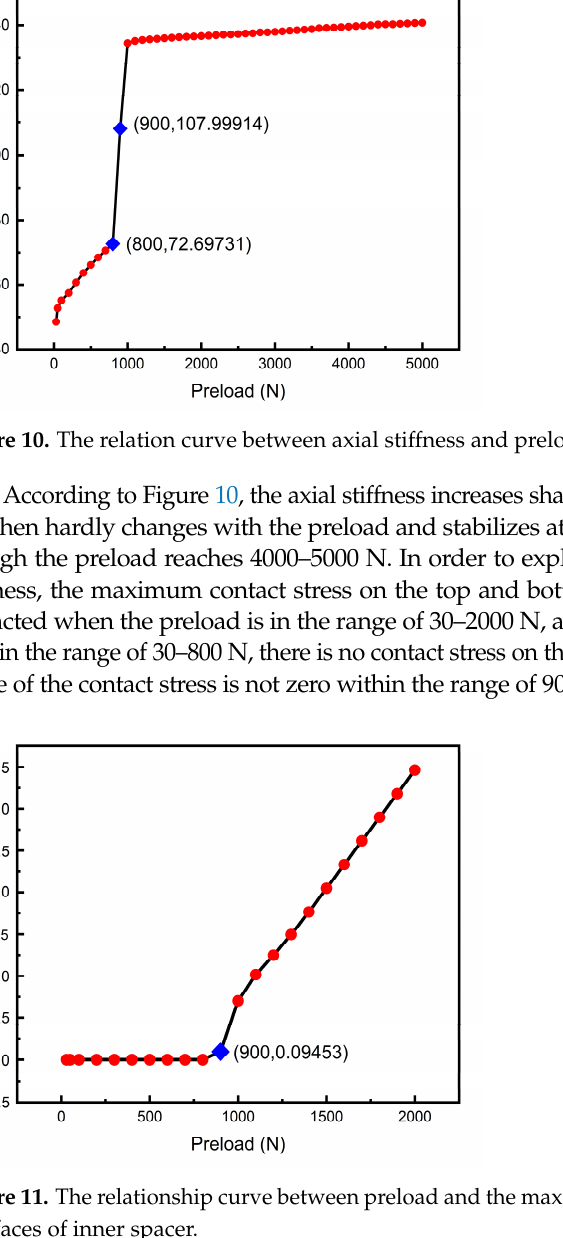
13 of 16 Figure 9. Comparison of F-l curve of bearing’s 2D model and fitting curve of stickout measuring experiment results. It can be concluded that the relationship curve between force (F) and displacement (l) calculated for the bearing equivalent 2D simulation model is well fitted with the ex- perimental results. Therefore, the stiffness of the actual bearing can be well simulated by using the 2D axisymmetric model with the rolling elements which have equivalent ma- terial parameters. 4.2. Contact Stress Calculation of 2D Bearing Model According to Section 3.3, the actual maximum contact stress of the 3D bearing can be calculated through the maximum contact stress of the 2D equivalent axisymmetric model by using Equation (35). By substituting the structural and material parameters of bearing into Equation (35), the power function relationships related to maximum contact stress of the bearing ring and balls in the 3D model and the 2D model can be obtained: For the inner ring: 𝜎 (cid:3040)(cid:3028)(cid:3051)(cid:2879)(cid:2871)(cid:3005) = 179.864 ∙ 𝜎 (cid:3040)(cid:3028)(cid:3051)(cid:2879)(cid:2870)(cid:3005)(cid:2868).(cid:2874)(cid:2874)(cid:2875) (36) For the outer ring: 𝜎 (cid:3040)(cid:3028)(cid:3051)(cid:2879)(cid:2871)(cid:3005) = 210.708 ∙ 𝜎 (cid:3040)(cid:3028)(cid:3051)(cid:2879)(cid:2870)(cid:3005)(cid:2868).(cid:2874)(cid:2874)(cid:2875)